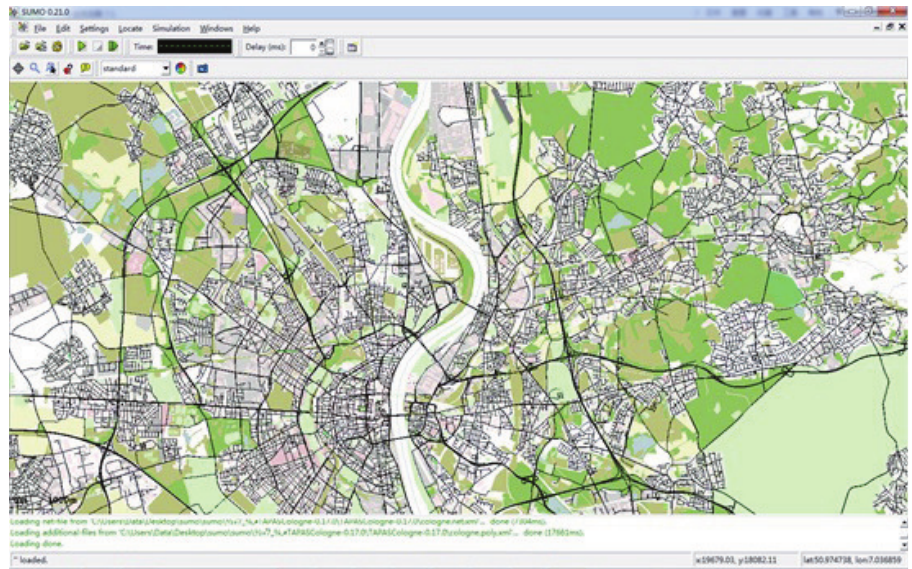
Figure 9. Interface for